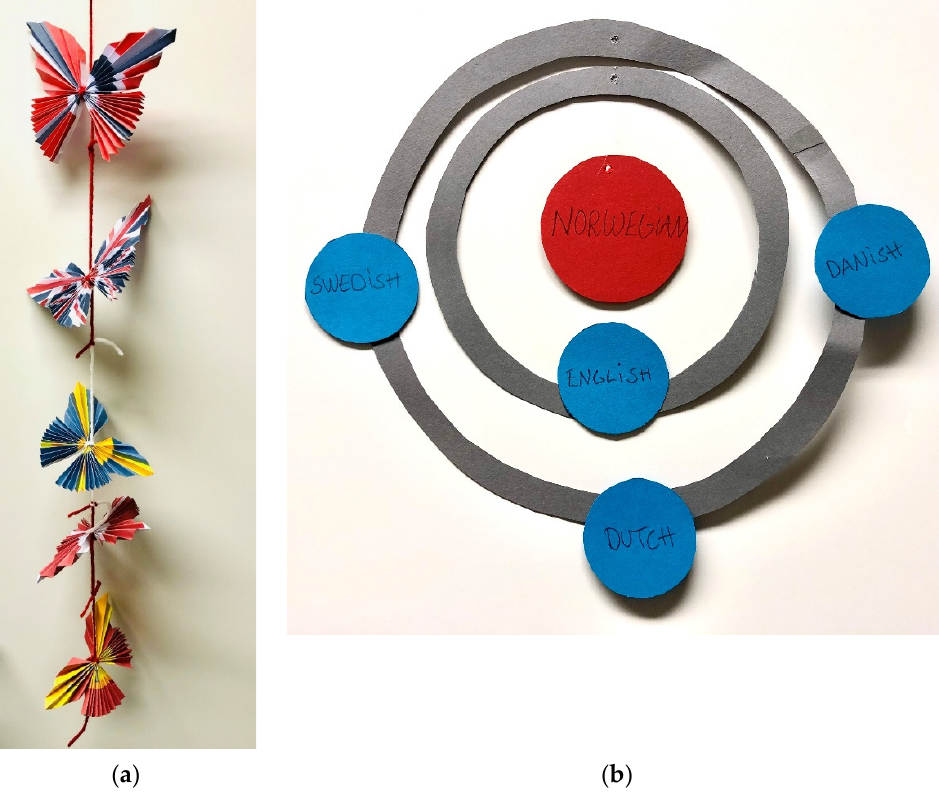
Figure 2. ST8’s ( a ) and ST14’s ( b ) DLC